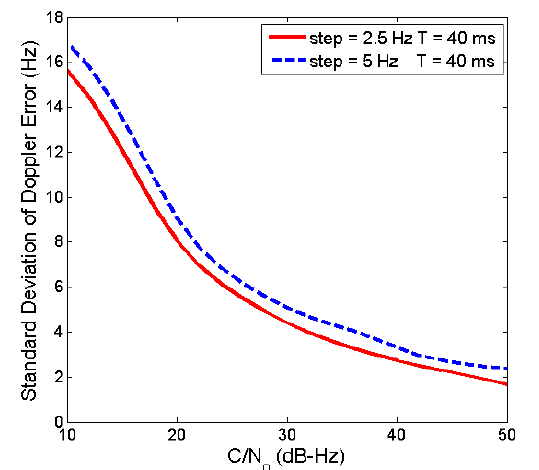
Figure 6. Detection probability of the Doppler frequency error.